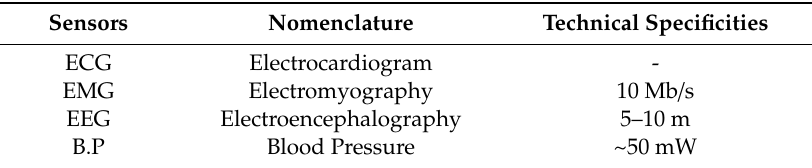
Table 1. Most used medical sensors and their technical